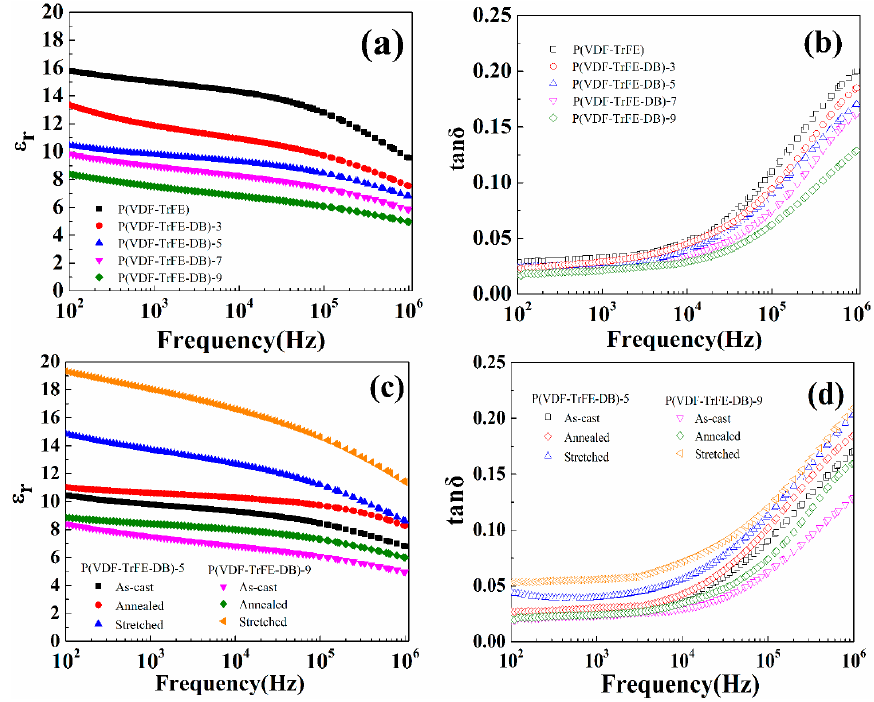
Figure 5. ε r and tan δ of the as-cast P(VDF-TrFE) (80/20 mol %) and P(VDF-TrFE-DB)s ( a , b ), and comparison for P(VDF-TrFE-DB)-5 and P(VDF-TrFE-DB)-9 with different treatment conditions ( c , d ).